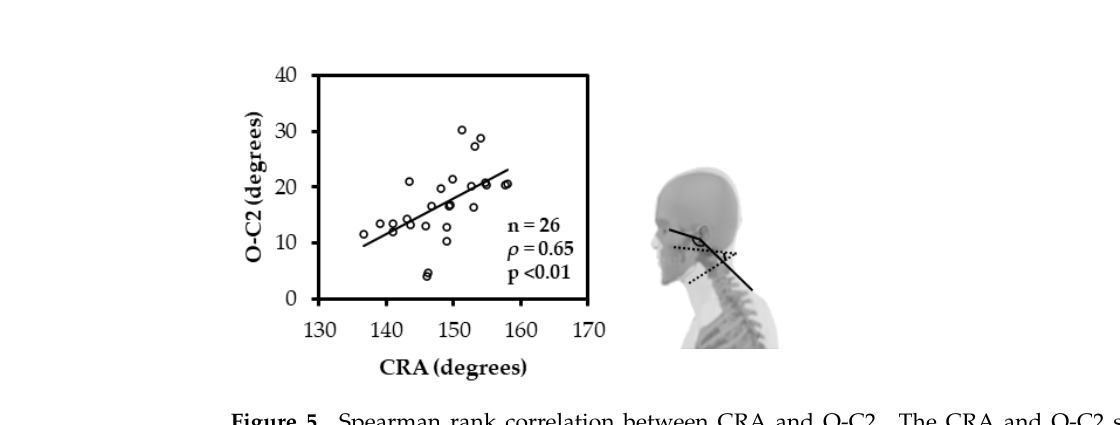
Figure 4. Spearman rank correlation between CVA and C2-7. The CVA and C2-7 had a significant positive correlation. (CVA: cranial vertical angle; C2-7: cervical lordosis).